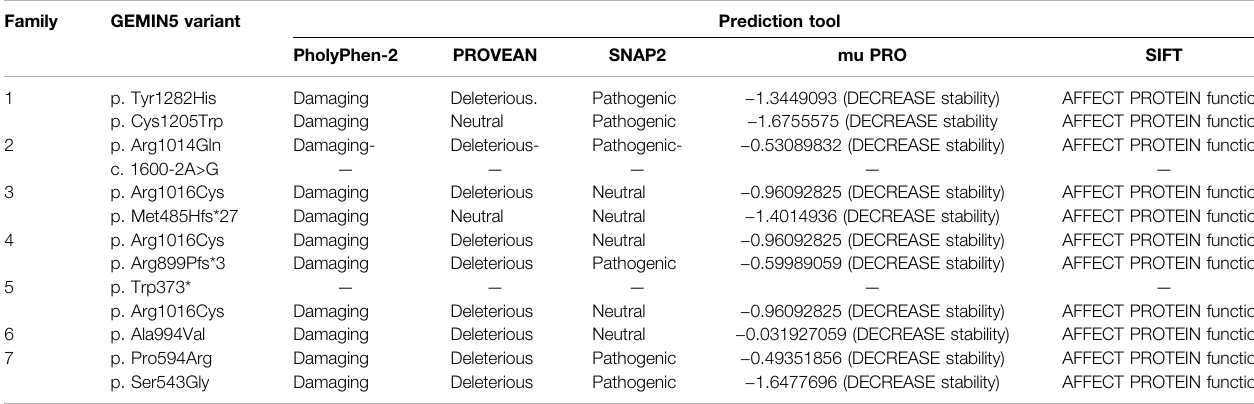
TABLE 3 | Allelic frequencies of the variants identi fi ed among our GEMIN5 patients. Family GEMIN5